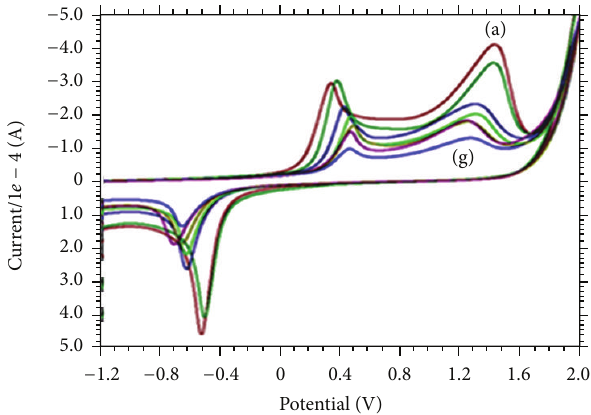
Figure 2: Influence of pH on the shape of the peaks in phosphate buffer solution at (a) pH 4.2, (b) pH 3.0, (c) pH 5.0, (d) pH 7.0, (e) pH 8.0, (f) pH 9.2, and (g) pH 10.4 with potential scan rate 50 mVs −1 .